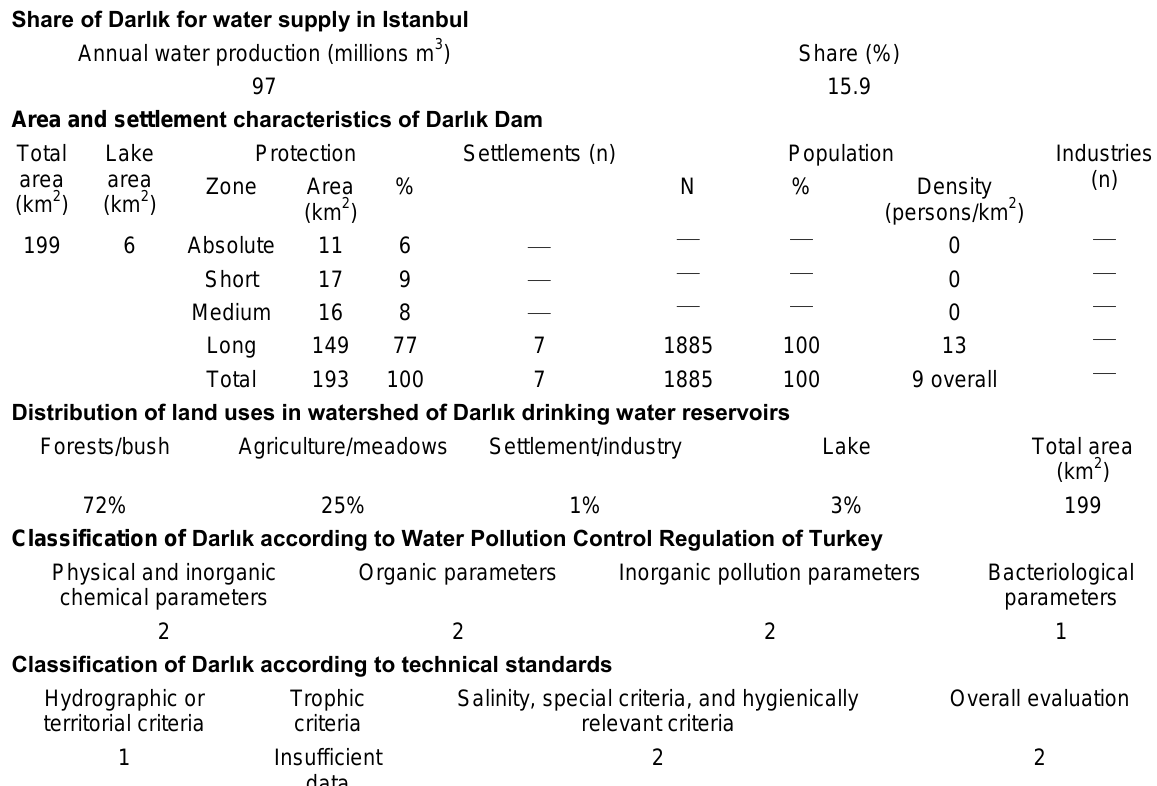
Statistical Information on Darlik